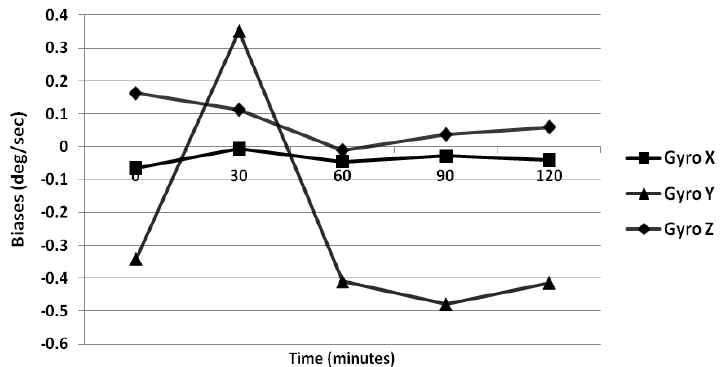
Figure 3. Gyroscope in-run biases (vary temp.).